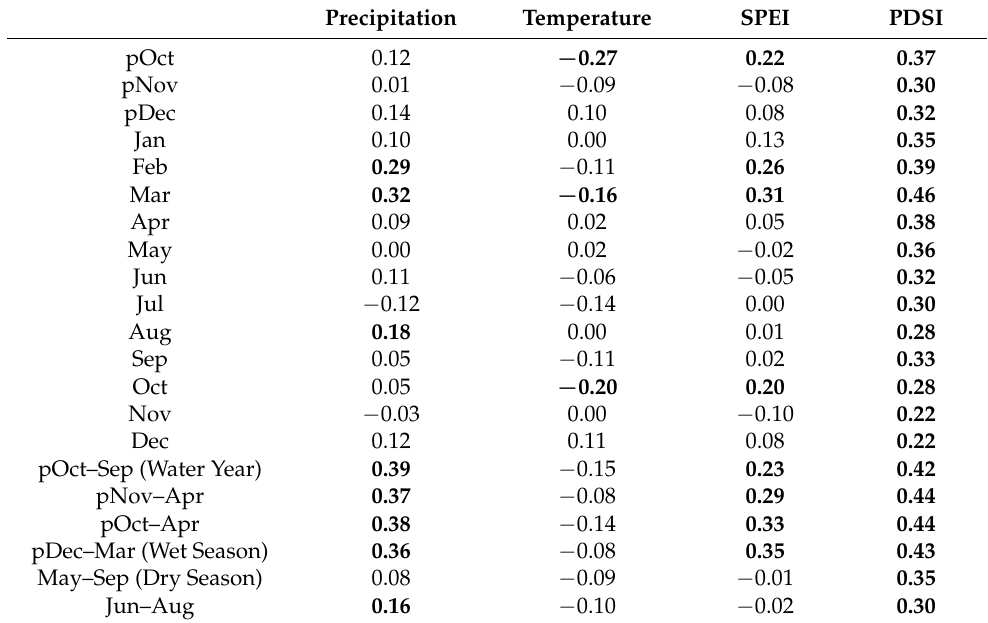
Table 2. Correlation coefficients between the tree ring chronology and monthly, seasonal, and annual climate trends and selected climate indices at Crestline, CA. Values in bold represent statistically significant correlations at the 95% confidence level ( p < 0.05) or